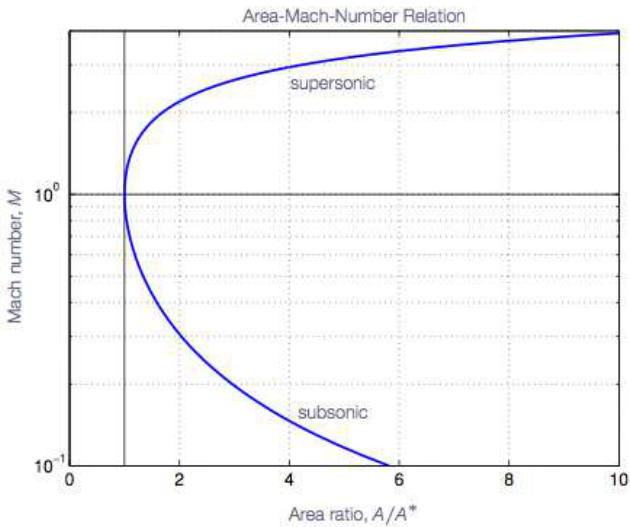
Figure 4. The area–Mach-number